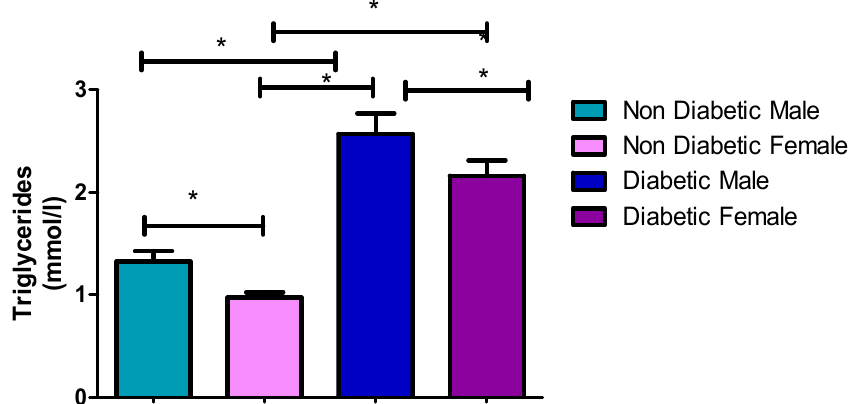
statistical bar.